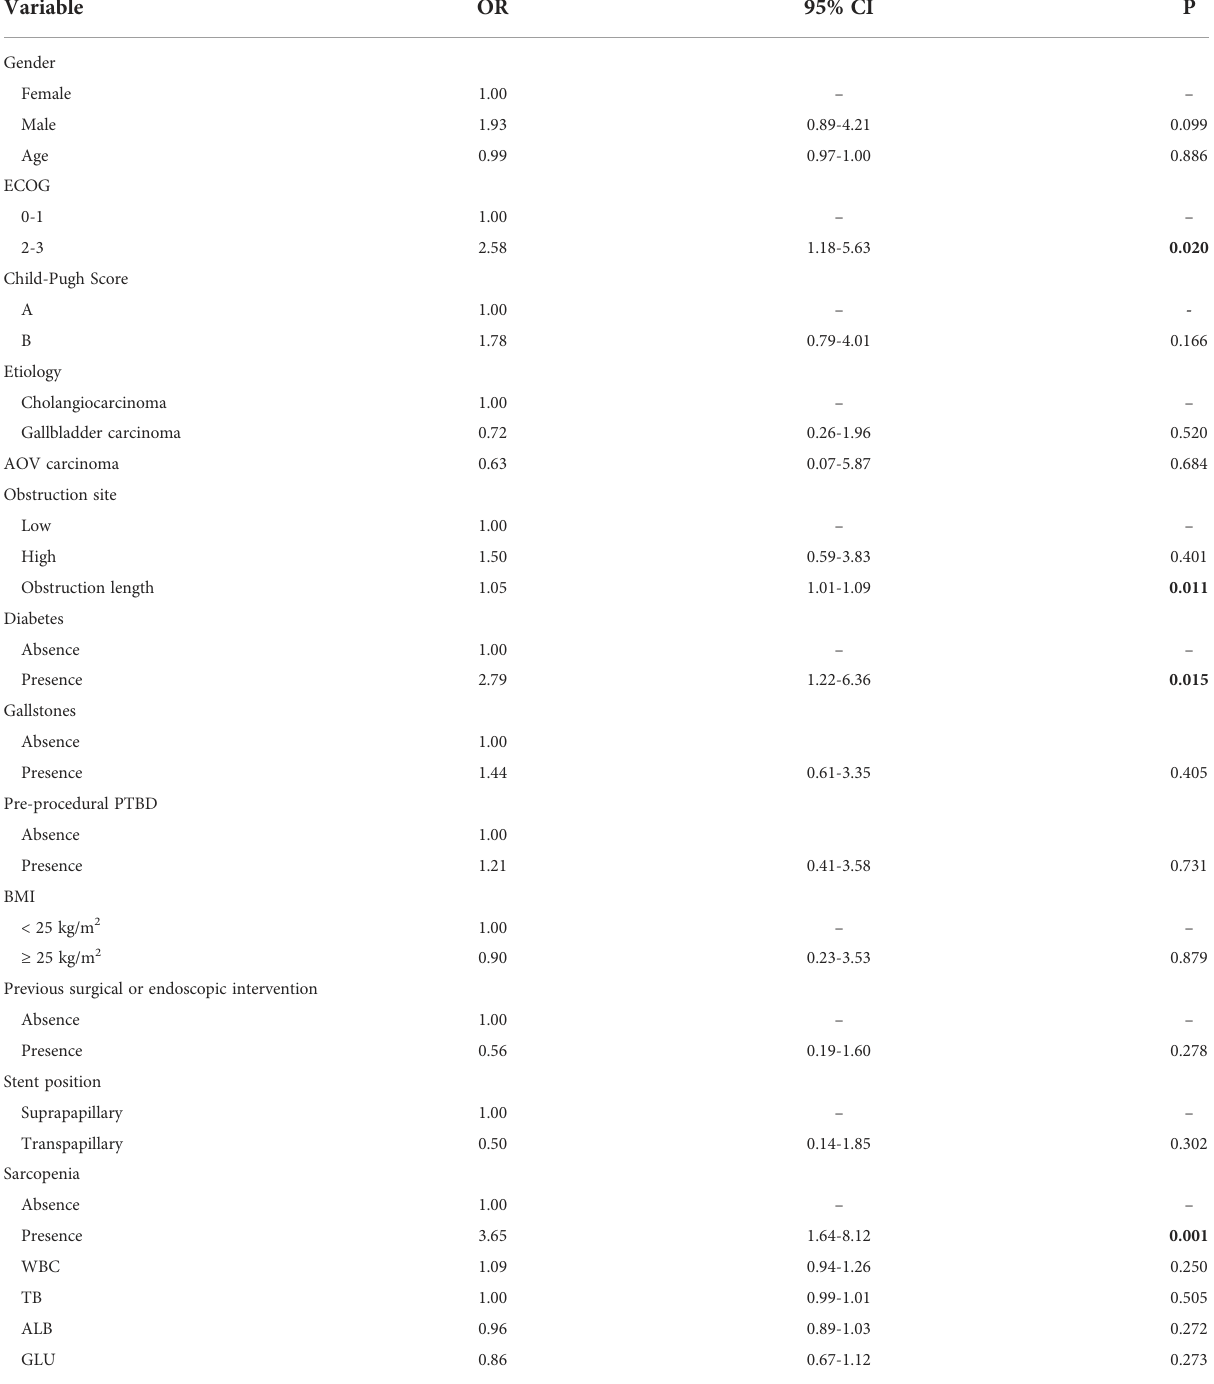
TABLE 2 Univariate analysis of risk factors for EBI in patients after PTBS.